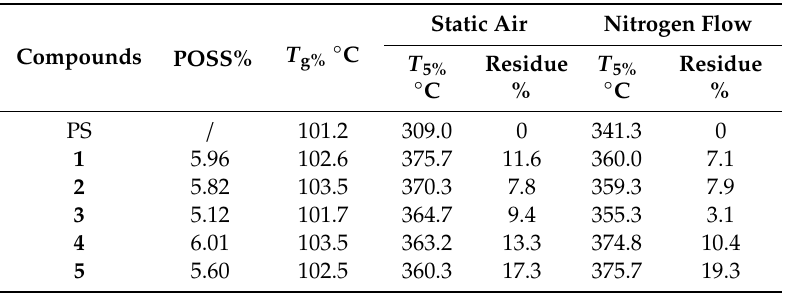
Table 3. POSS content ( w / w ), glass transition temperatures ( T g ), temperatures at 5% mass loss ( T 5% ), residue percentage at 700 ◦ C of PS, and nanocomposites in a static air atmosphere and in flowing